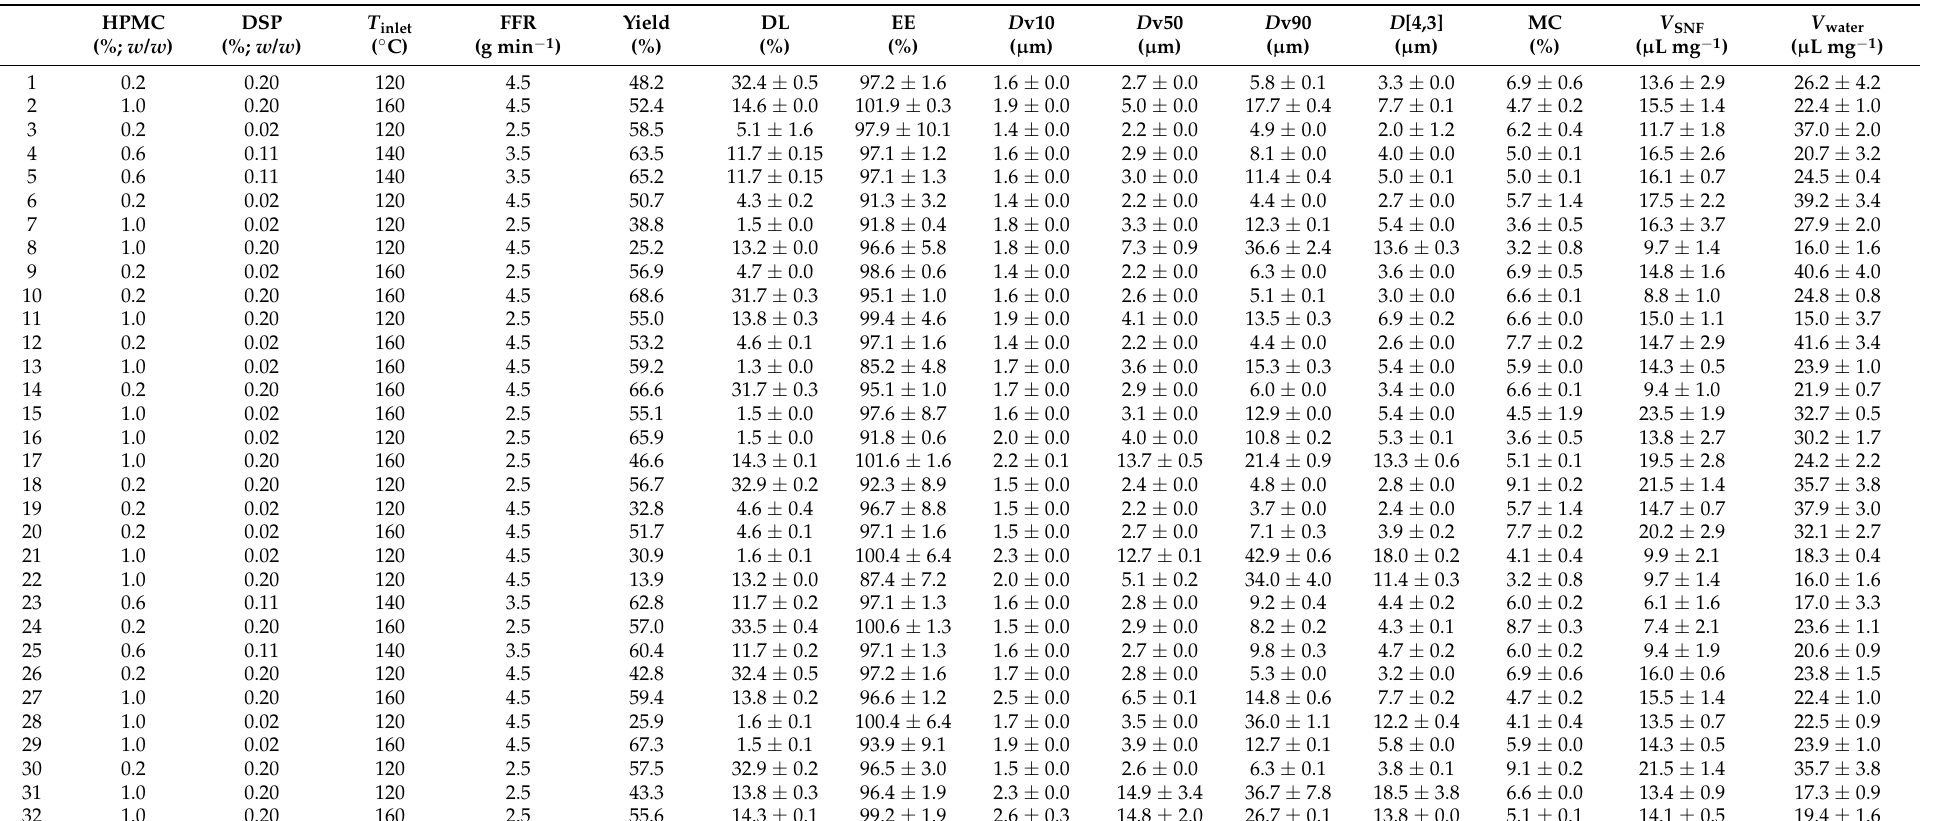
Table 1. Sample sequence from design of experiment and corresponding spray drying process yield, microspheres drug loading (DL), drug entrapment efficiency (EE), particle size distribution ( D v10, D v50, D v90 and D [4,3]), residual moisture content (MC) and swelling properties expressed as volume of SNF ( V SNF ) and water ( V water ) absorbed per mg of microspheres in the swelling